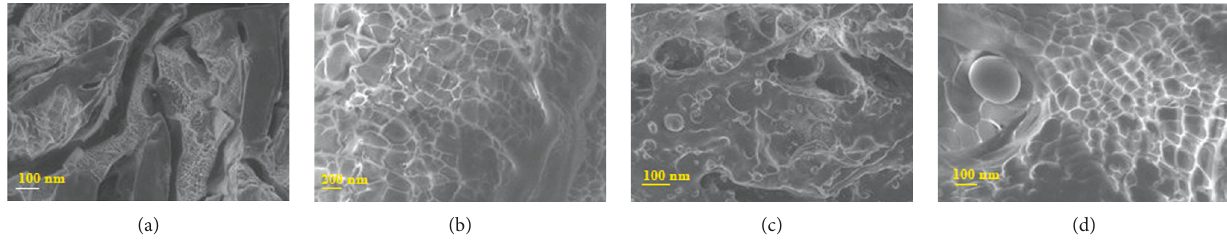
Figure 4: TEM pictures of the hydrogel (hydrogel (a, b, c, and d)) made of polyacrylamide, polyaniline, and